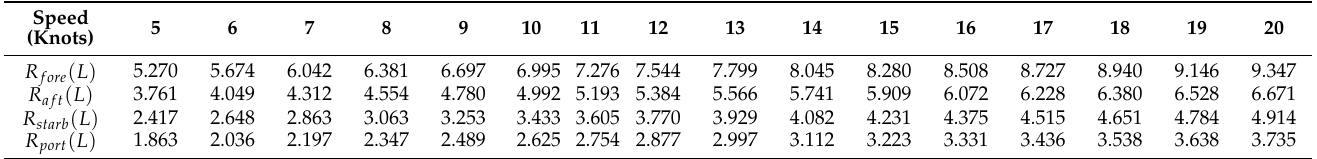
Table 2. The radius changes of dynamic Elliptical ship domain.